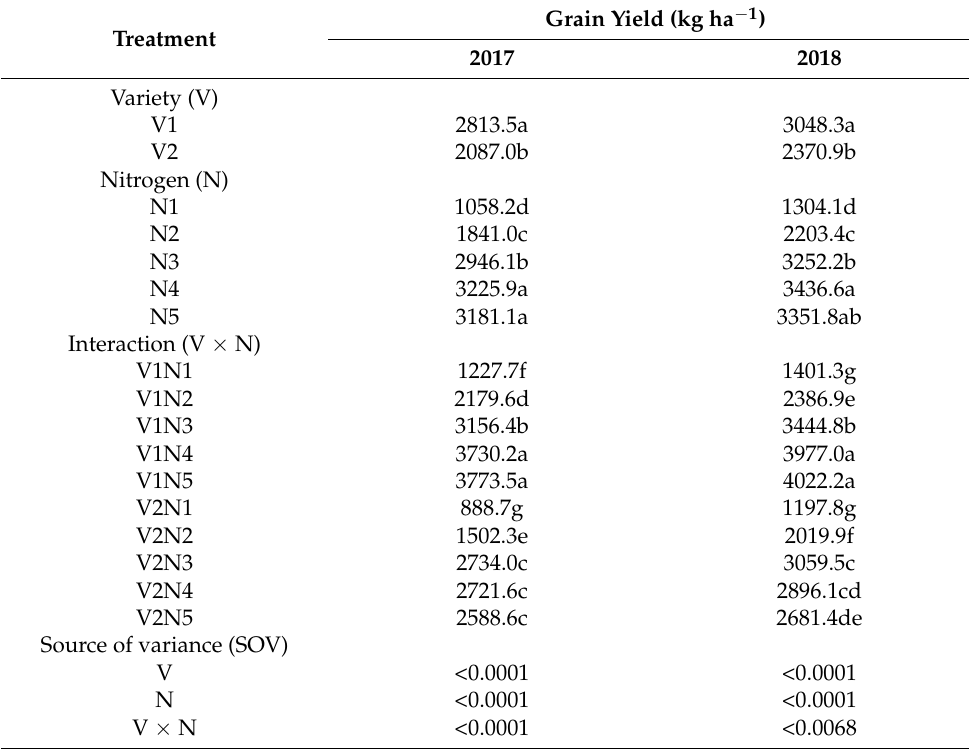
Table 1. Millet grain yield in response to different varieties and nitrogen rates during the 2017 and 2018 growing